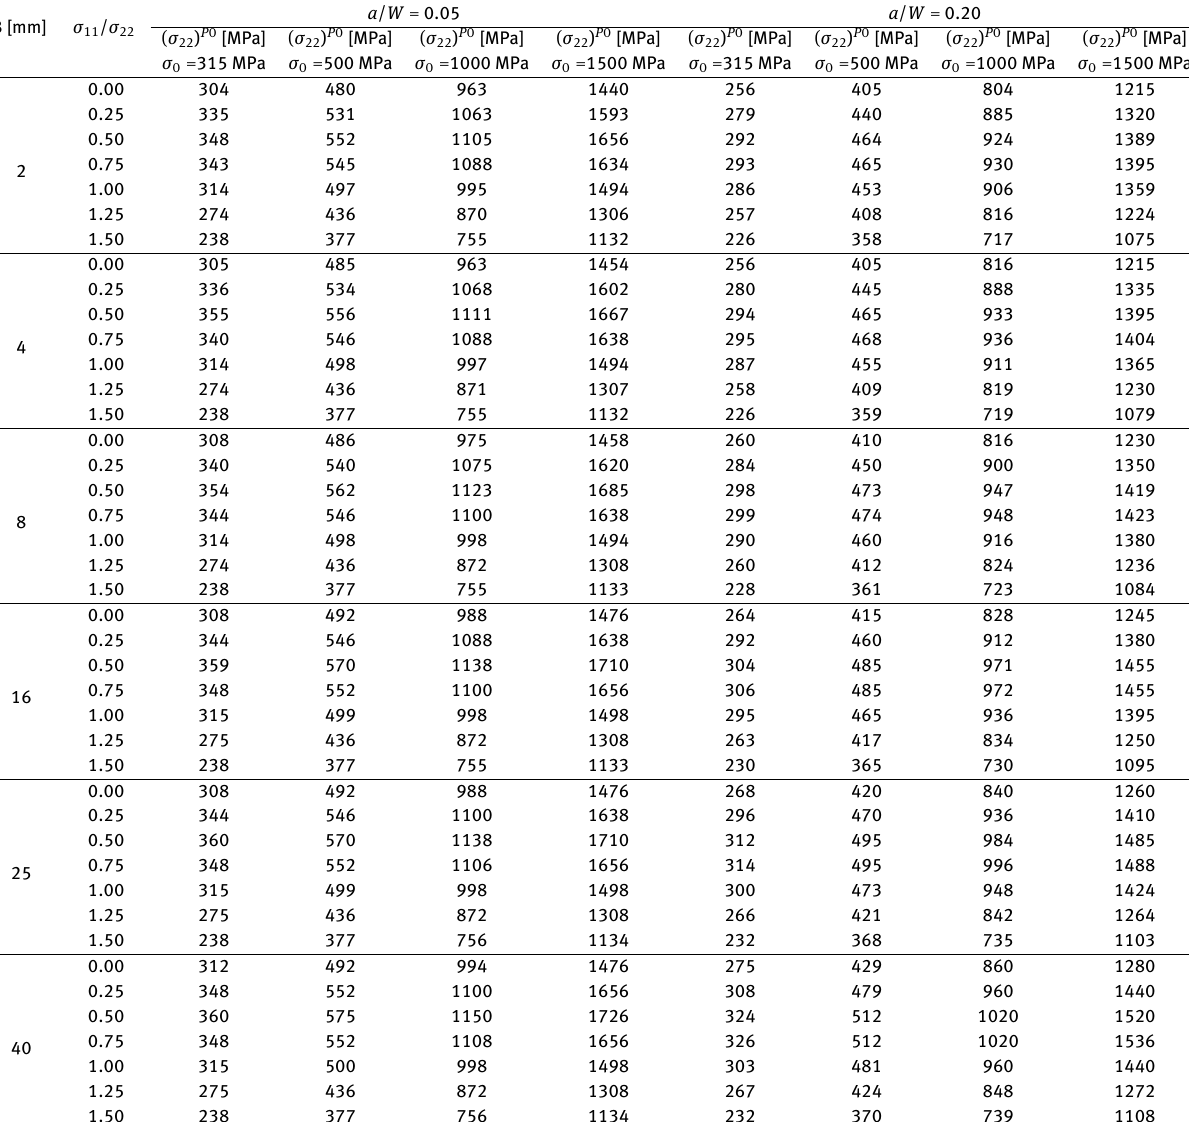
Table 4: Numerically calculated values of the limit load ( σ 22 ) P 0 for CCSP(BT) (3D problems) at the relative crack lengths a / W = 0.05 and a / W =